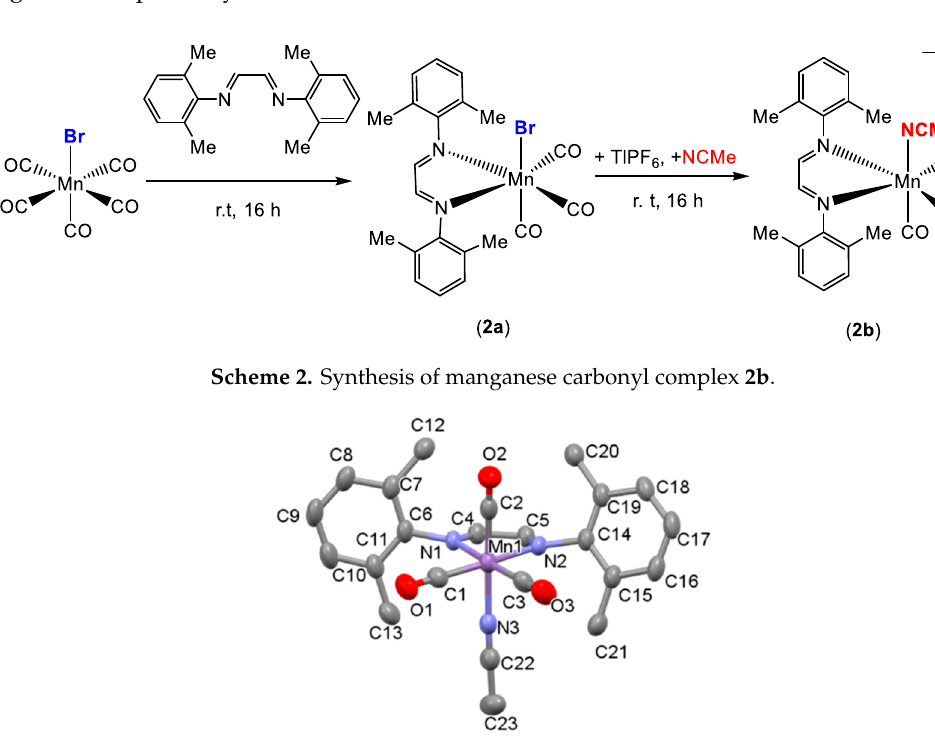
Figure 3. Thermal ellipsoid (50% probability level) plot of the solid-state structure of 2b with select atom labeling. Hydrogen atoms and the PF 6 ion are omitted for clarity. Selected bond lengths (Å):